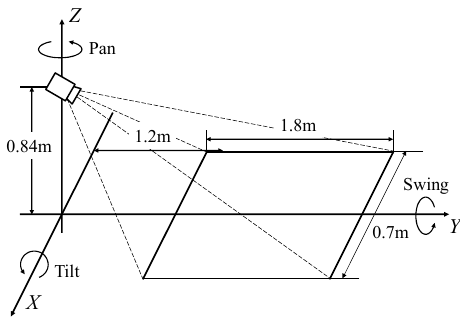
Figure 6. Installation of the Kinect, and the static hazardous object detection area.